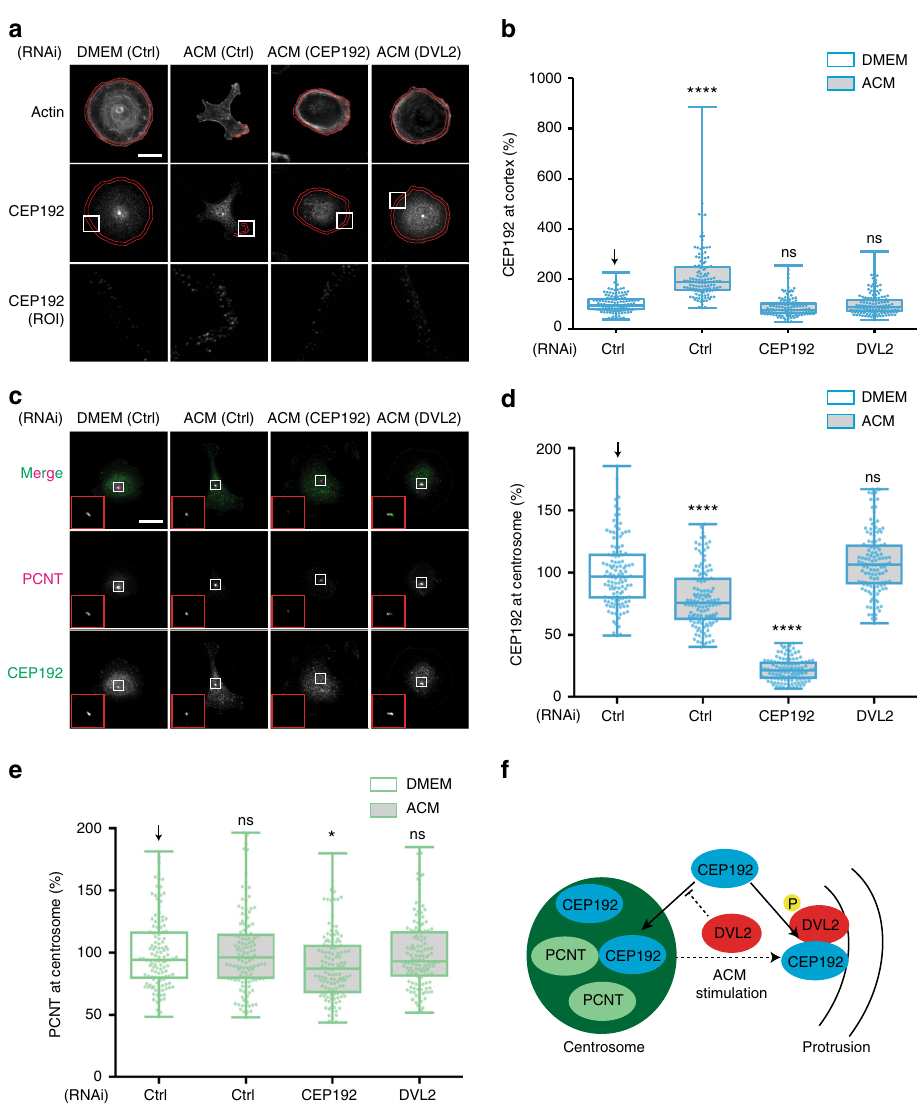
Fig. 5 DVL2 orchestrates the recruitment of CEP192 at protrusions. a , c MDA-MB-231 cells were transfected with control, CEP192 or DVL2 siRNAs for 72 h, and then stimulated overnight with DMEM or ACM. Cells were stained for ( a ) CEP192 and actin, or ( c ) CEP192 and PCNT. Bar = 20 µ m. b , d , e Intensity of CEP192 at cell cortex ( b ), at centrosome ( d ), and PCNT signal at centrosome ( e ) was measured as described in Methods and plotted as box and whiskers. Boxes represent median and 25th to 75th percentiles, whiskers the minimum and maximum values with each individual value superimposed. The data were compared with one-way ANOVA Kruskal – Wallis test and post-tested with Dunn ’ s multiple comparison test. Arrow indicates the control bar used for comparison. (* p < 0.05, **** p < 0.0001; n = 3, at least 60 cells were measured per condition). Light blue is CEP192, light green is PCNT. f Model for regulation of centrosomal and cortical CEP192 pools by